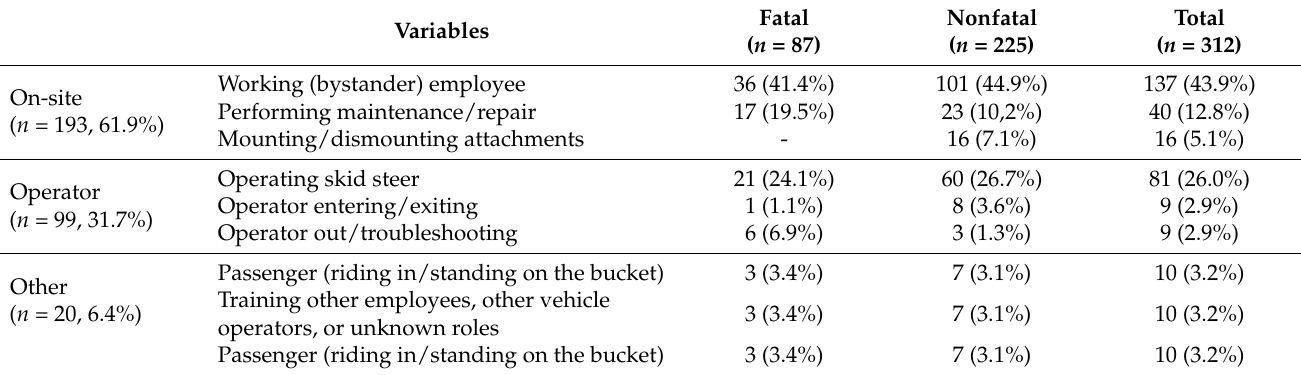
Table 4. Categorization of skid steer injury incident types by the role of the employee.